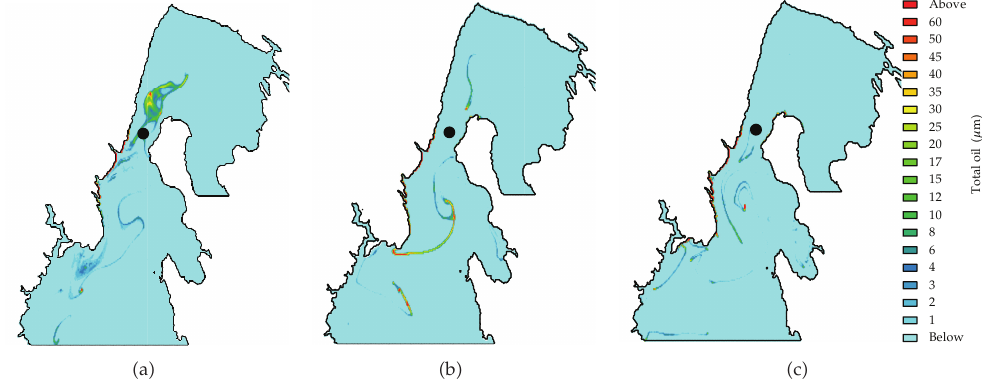
Figure 11: Oil pollution clouds for the 108th (cid:4) a (cid:5) , 150th (cid:4) b (cid:5) , and 192nd (cid:4) c (cid:5) hours after the spill onset at the position 1 (cid:4) Vela Vrata—black rectangle (cid:5) in the summer period (cid:4) 21/7/08–31/7/08 (cid:5) .